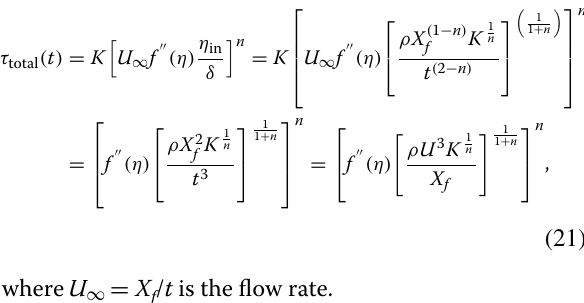
results or models, allowing us to calculate the time to form deformed streak lines and the flow stress. f y 0 can be obtained from the calculation of f =